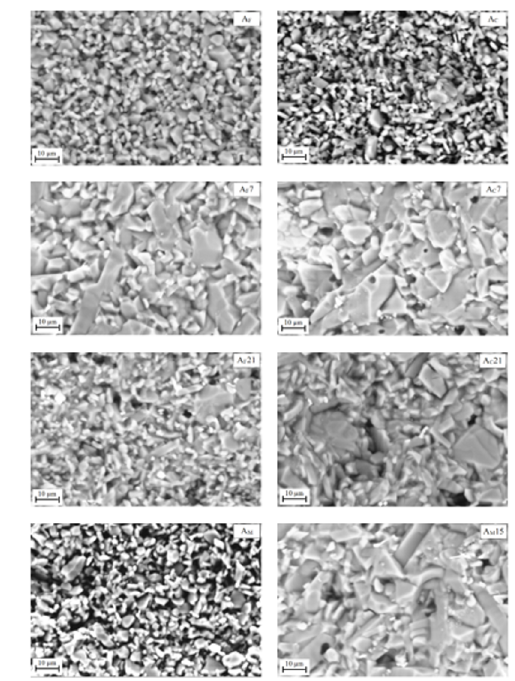
Figure 9. SEM observations of the alumina ceramics and LZSA/ alumina composites: fractured specimens.